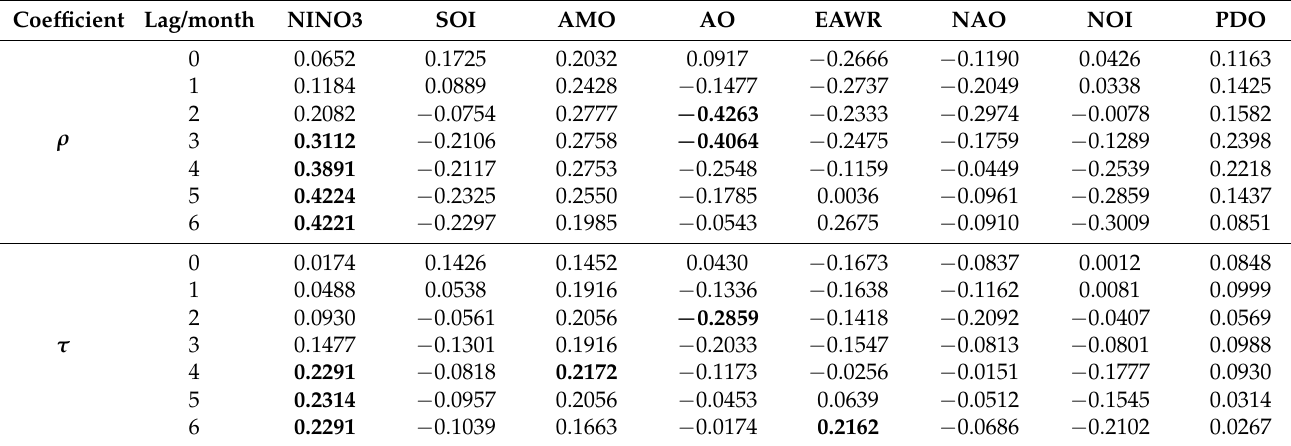
Table A3. The Pearson correlation coefficient ρ and the Kendall correlation coefficient τ between the time series of summertime precipitation and climate indices under lags from 0- to 6- month. Bold means statistically significant at the level of 0.05.